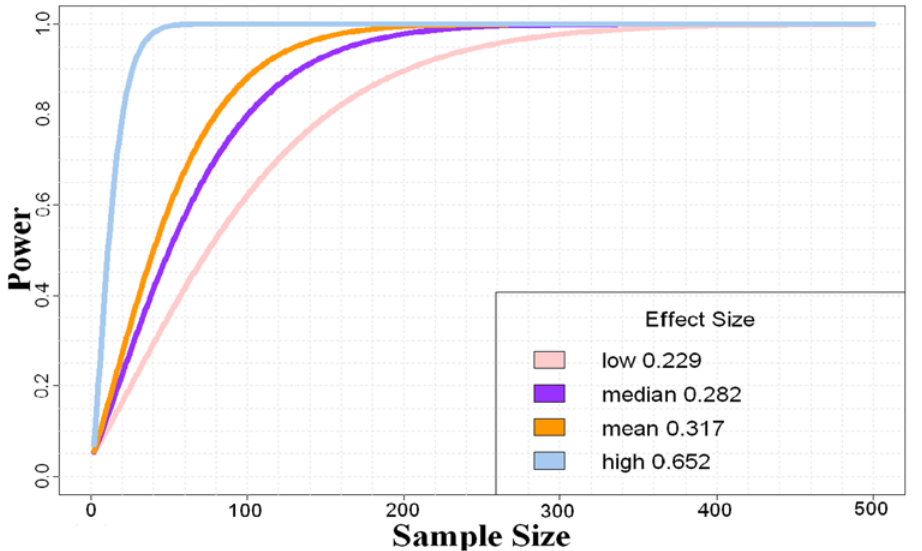
Figure 4. Power curves and sample size estimation under different views of effect sizes. The significance level is set as 0.05.